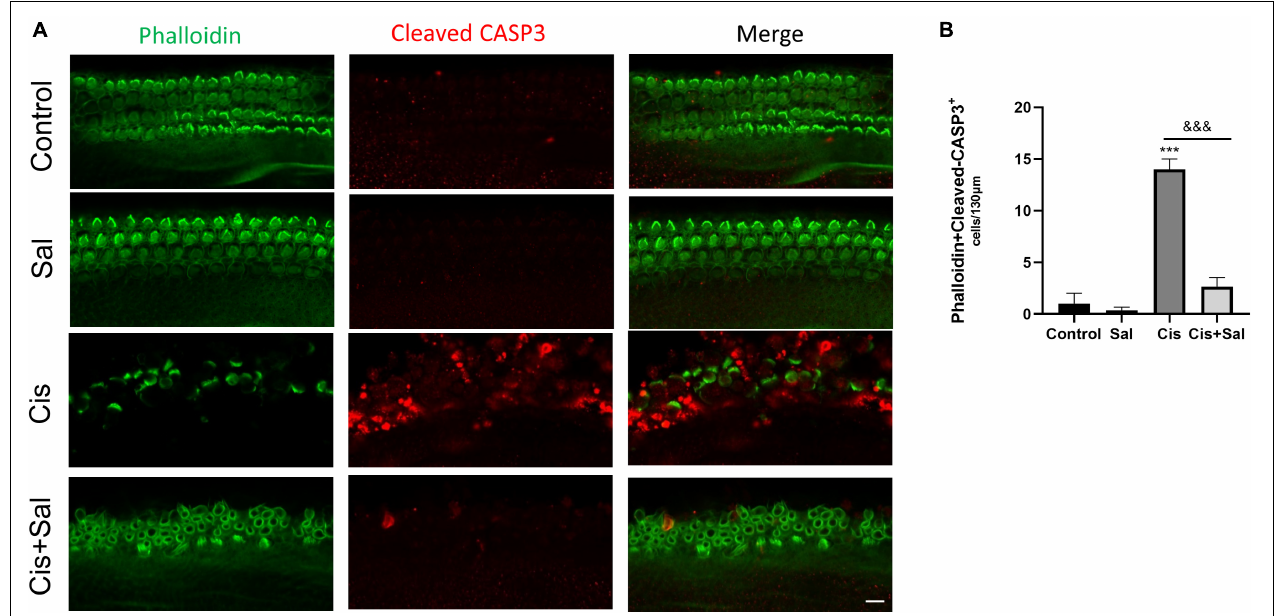
FIGURE 4 | Cisplatin-induced hair cell apoptosis decreases after treatment with Sal. (A) Number of cleaved caspase-3-positive cells (red) decreased in the 20 µ M cisplatin + 10 µ M Sal group compared with that in the cisplatin group (middle turns). (B) Quantification of the number of phalloidin + cleaved caspase-3 double-positive cells in (A) . Values are presented as mean ± SEM from independent experiments. *** P < 0.001 vs. the control group; &&& P < 0.001 vs. the cisplatin group. Scale bars = 10 µ